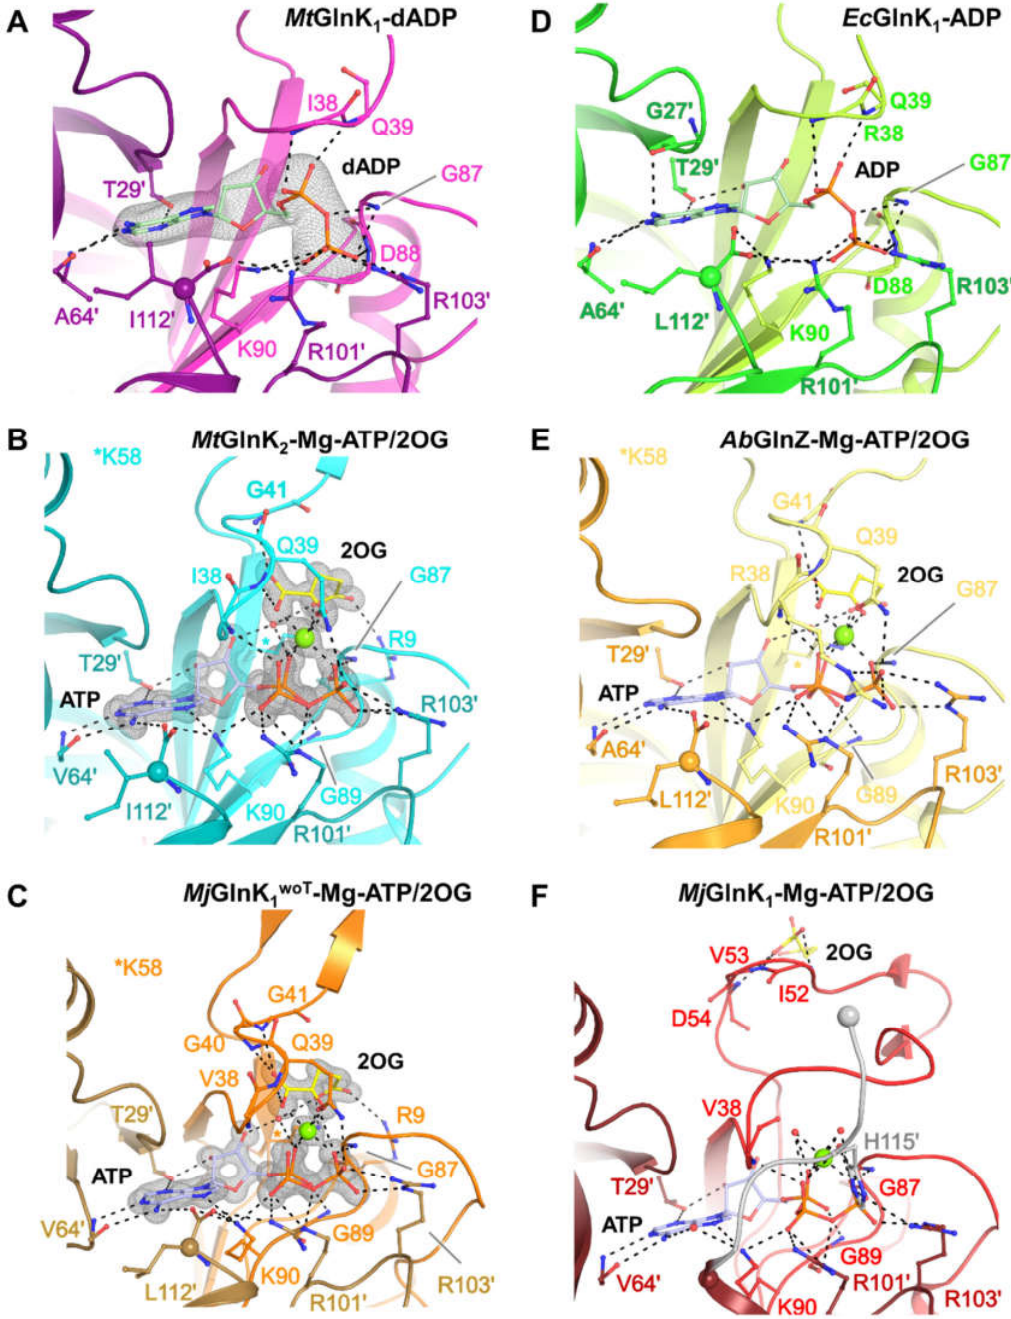
Figure 1. Ligand binding sites. For all panels, the main chain is represented with cartoon. Ligands and main and side chains of the residues participating in ligand binding are shown as balls and sticks. Carbon atoms are colored in yellow for 2OG, in pale green for dADP and ADP, and in pale blue for ATP, while nitrogen, oxygen, phosphorus, and Mg are colored in blue, red, orange, and green, respectively. C-termini are highlighted by a sphere. Electron density maps (2 F o – F c ) around the ligands are contoured at 2- σ and shown as gray mesh. Polar contacts are indicated by black dashes. ( A ) Mt GlnK 1 -dADP, ( B ) Mt GlnK 2 -Mg-ATP/2OG, ( C ) Mj GlnK 1 woT -Mg-ATP/2OG, ( D ) E. coli GlnK-ADP (PDB:2NUU), ( E ) Azospirillum brasilense GlnZ-Mg-ATP/2OG (PDB:3MHY), ( F )